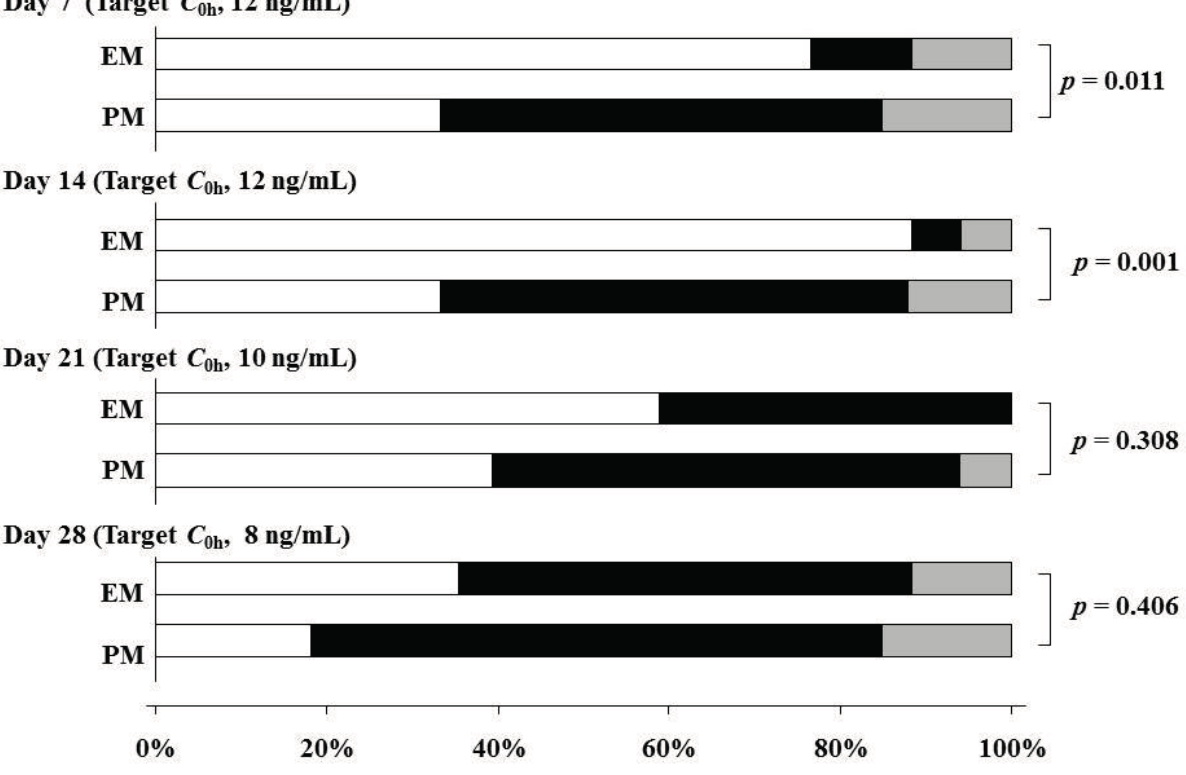
Figure 3. Comparison of achievement rates from the initial C 0h to the target range (target C 0h ± 20%) between CYP3A5 genotypes at each stage after renal transplantation. White columns, lower than the target range; black columns, within the target range; gray columns; more than the target range. EM ( *1 / *1 + *1 / *3 ), n = 17; PM ( *3 / *3 ), n =